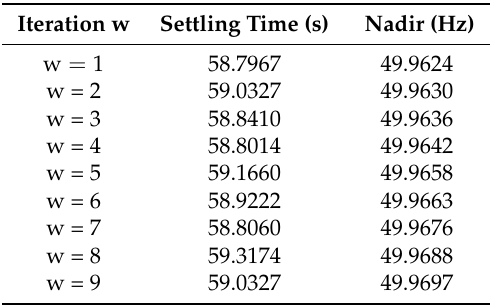
Table 2. Settling time and nadir development during the optimization process.